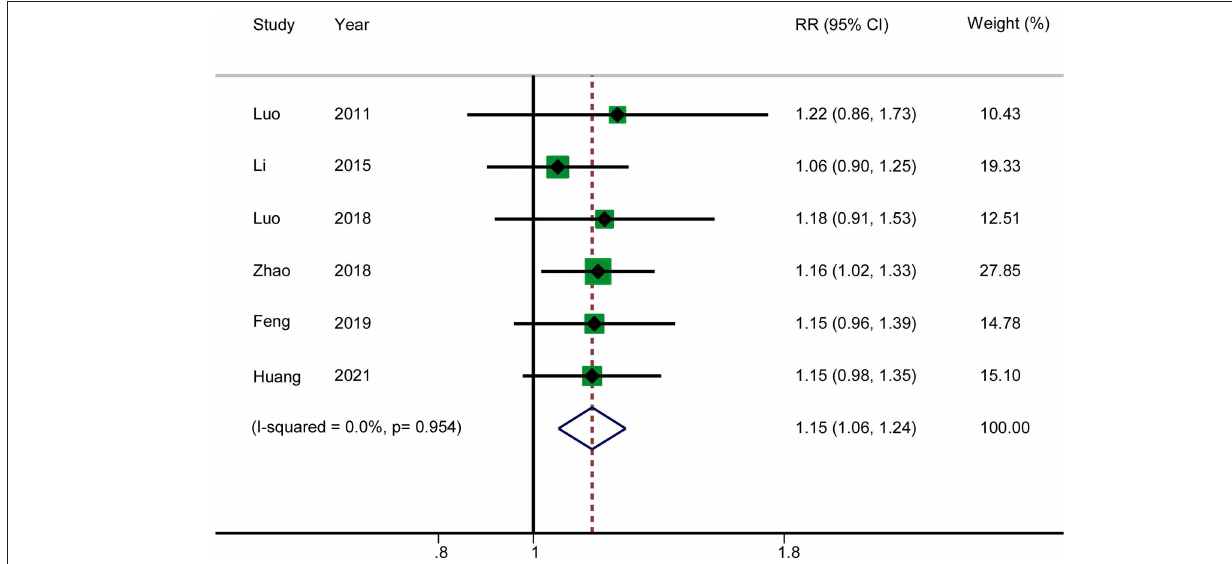
FIGURE 3 | Meta-analysis of total effectiveness rate.